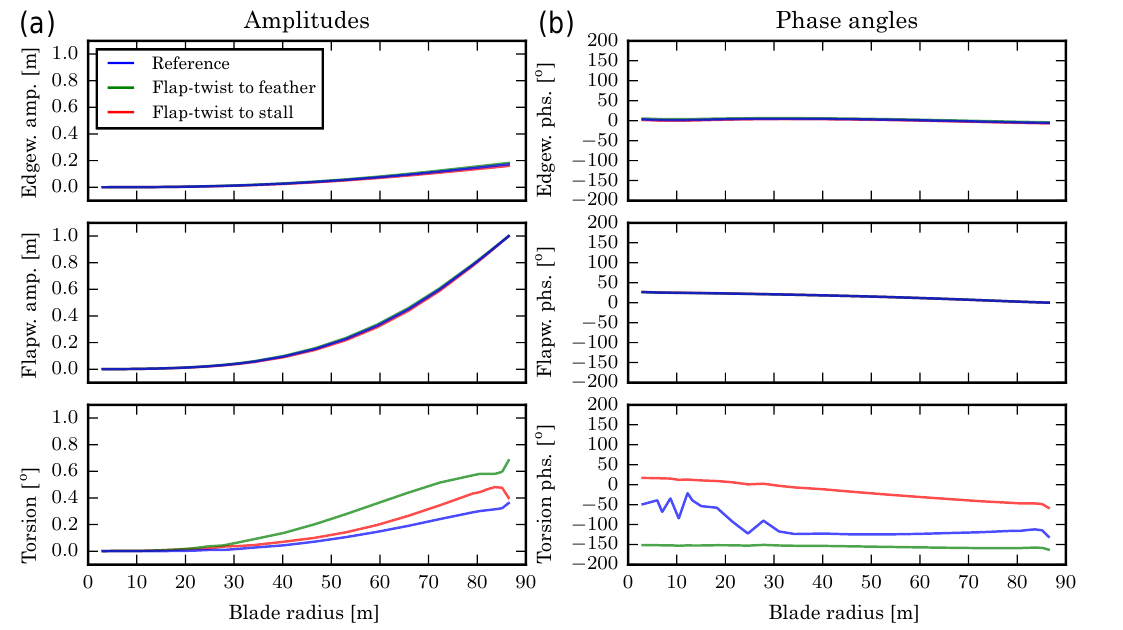
Figure 14. Amplitudes (a) and phase angles (b) of the first aeroelastic flapwise mode at 8ms − 1 wind speed for the reference (blue), flap– twist to feather (green), and flap–twist to stall (red) coupled DTU 10MW RWT blade. Coupling coefficient is γ y = ± 0 . 1 constant along the blade. Amplitudes are normalized to 1.0m tip deflection in the flapwise direction, and phase angles are relative to the flapwise tip deflection.